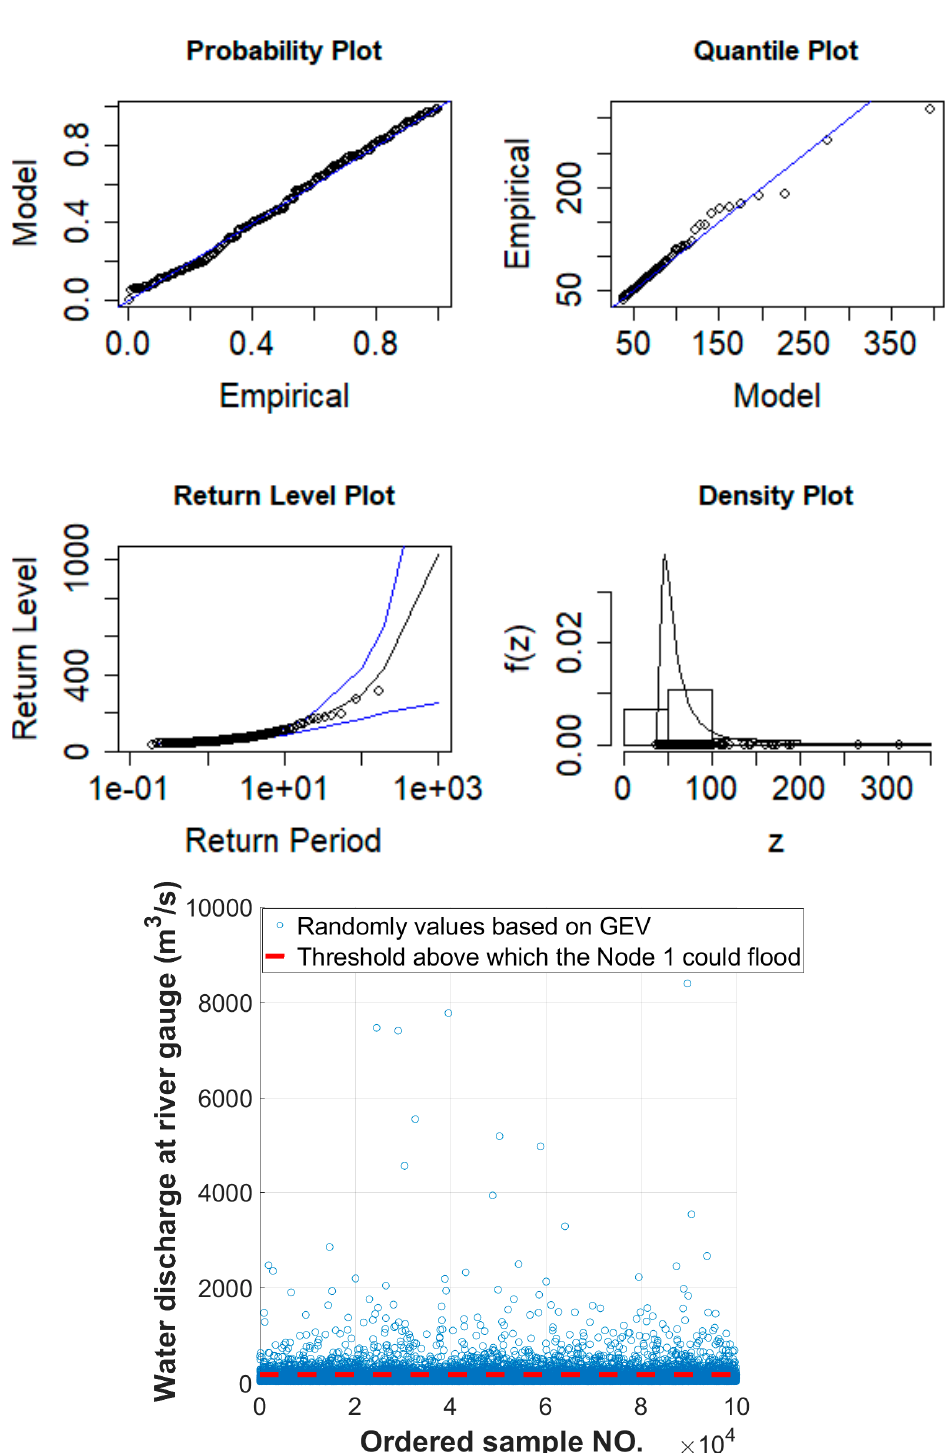
Figure 7. GEV diagonal fitting for annual maximum river gauge data and the return periods of water discharges at the river gauge. Bottom: the peak flood values are selected for the present scenarios.